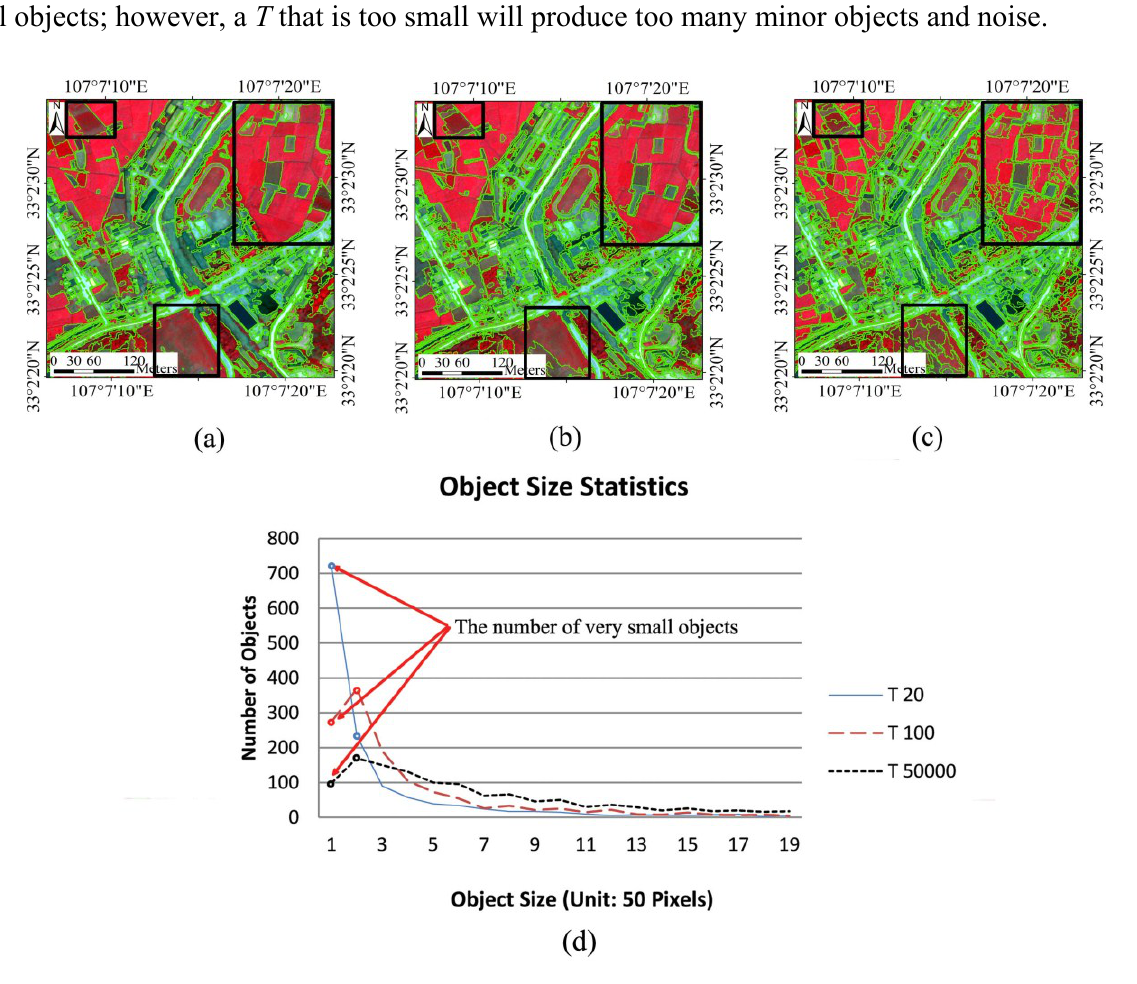
Figure 7. The influence of T in constrained spectral variance difference (CSVD). Images ( a – c ) are the segmentation results of R1. All three tests feature an initial scale of 20, an ε of 0 and 1400 segments. However, in ( a – c ), T was set to 20, 100 and 50,000, respectively. Panel ( d ) is a statistical graph of the number of objects with sizes smaller than 1000 pixels in ( a – c